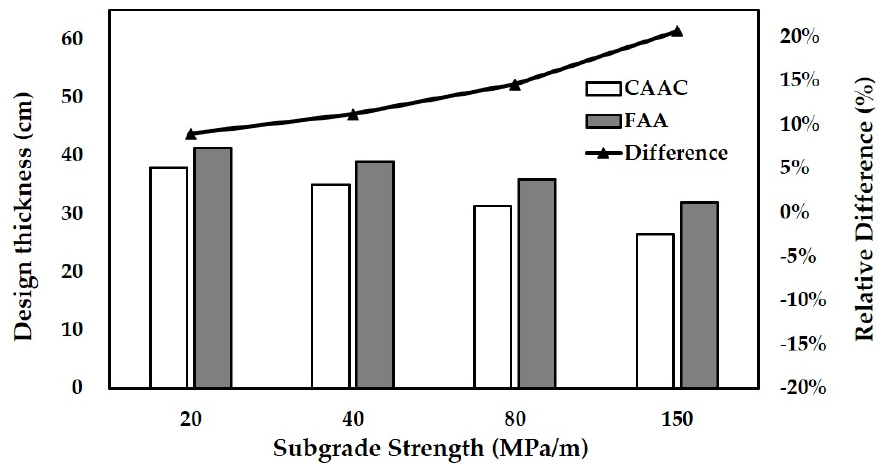
Figure 11. Designed thickness of concrete slabs for different subgrade strengths.